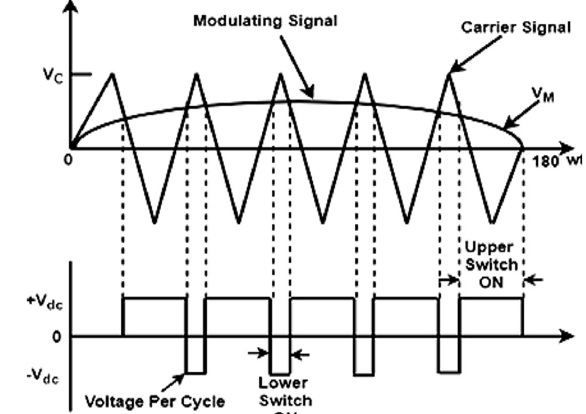
FIG.7. BASIC PRINCIPLE OF SINUSOIDAL